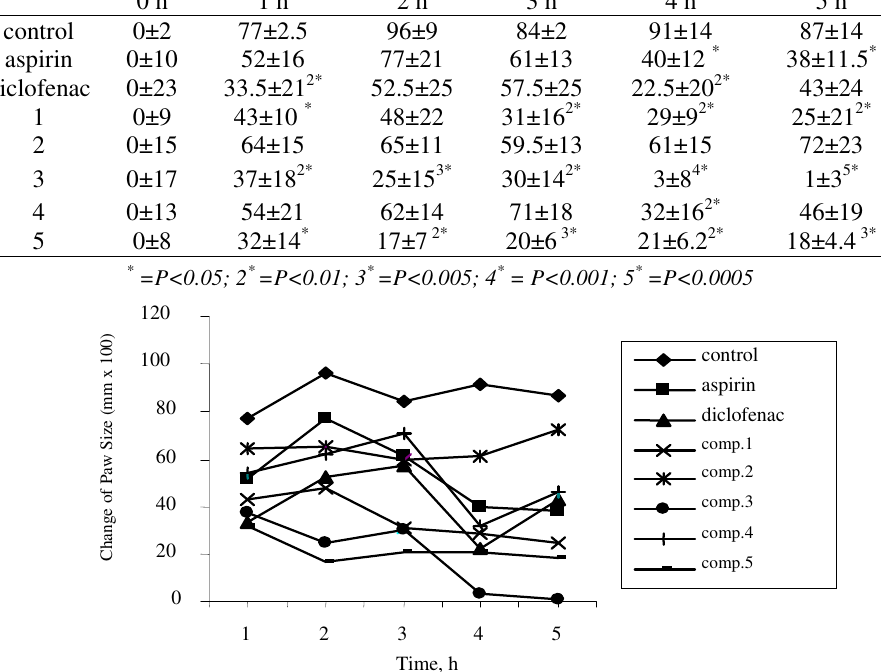
Table 7. Formalin induced inflammation tests of histidine derivatives change of paw size, mm × 10 -2 comp.